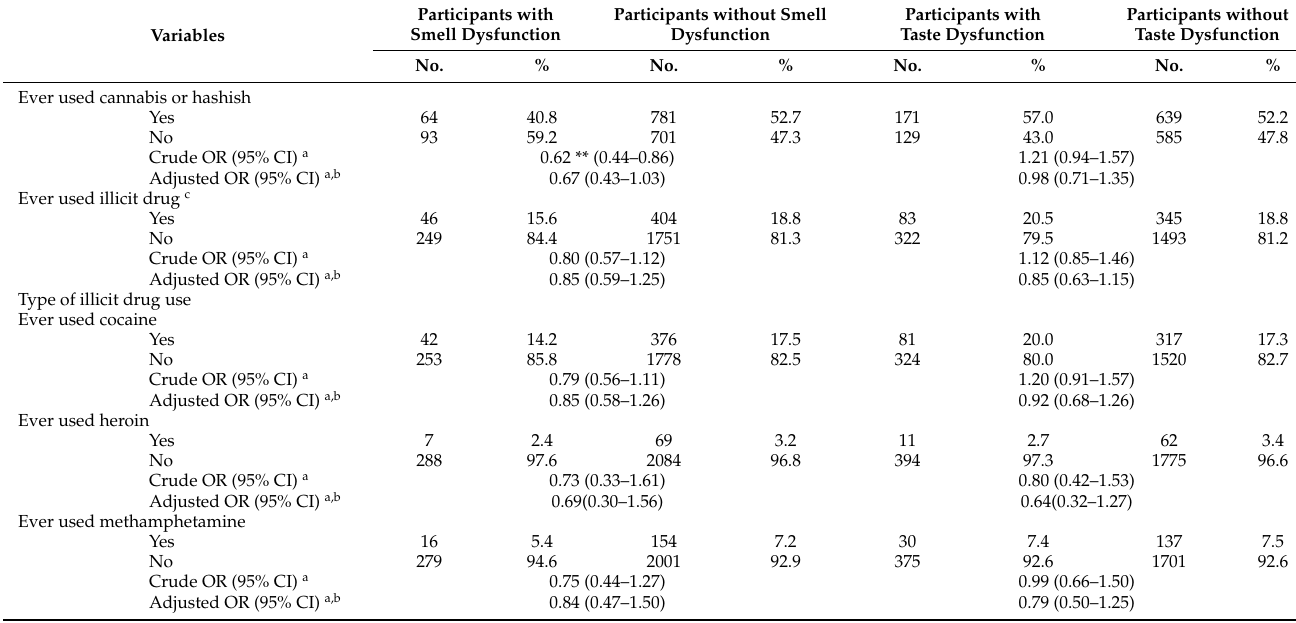
Table 2. Prevalence and odds ratios for cannabis and illicit drug use among study participants with and without smell and taste dysfunction.